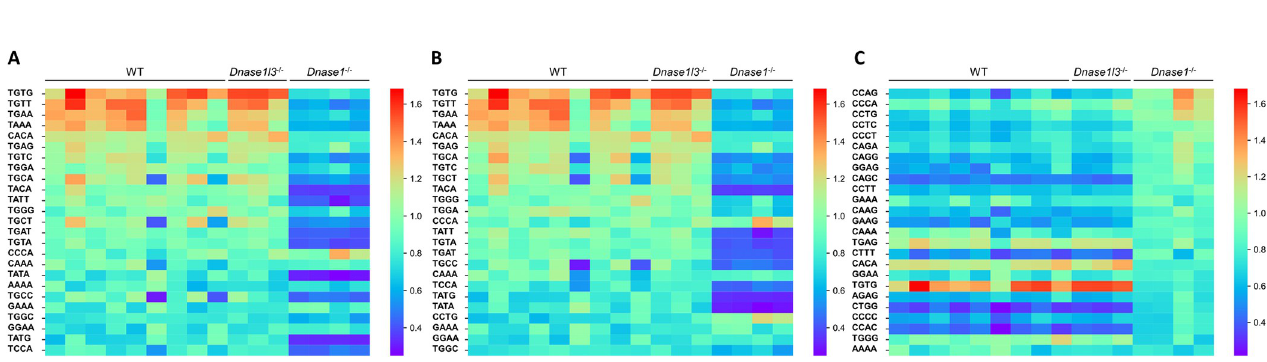
Fig 4. Heatmap showing the end motifs of ucfDNA among different groups. The top 25 4-mer motifs were ranked in descending order according to the frequencies in WT (A), Dnase1l3 -/- (B) and Dnase1 -/- (C).